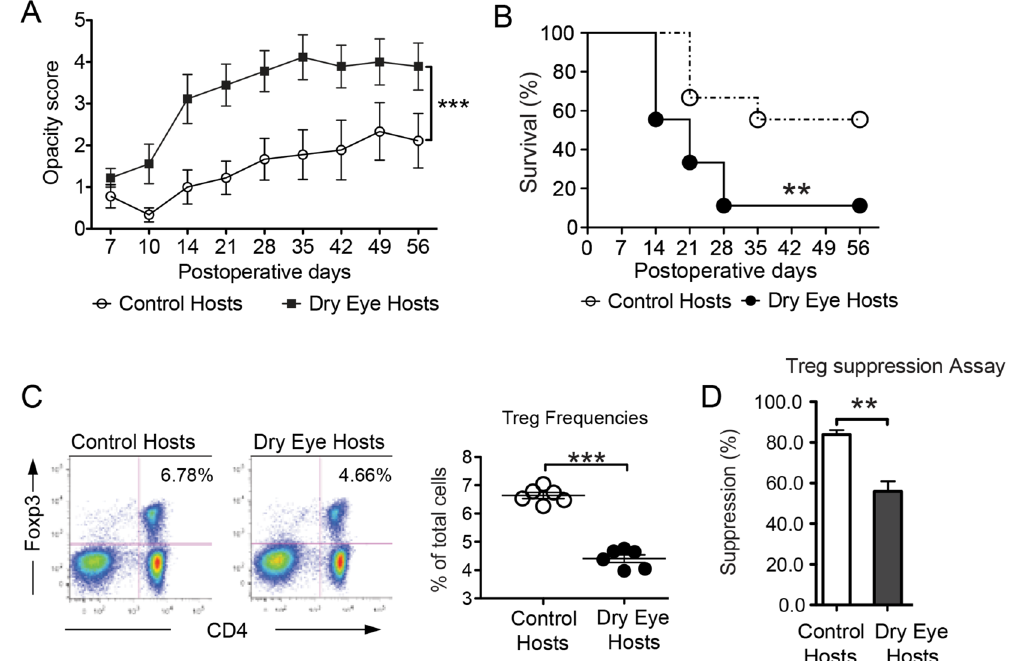
Figure 1. Dry eye disease reduces graft survival and Treg function after allograft survival. Healthy corneal grafts were transplanted on normal control hosts or dry eye (DED) hosts. ( A ) Corneal graft opacity ( *** p < 0.001) and ( B ) graft survival were assessed for 8 weeks (n = 10/group, ** p < 0.01). Draining lymph nodes were harvested 2 weeks post-transplantation. Single cell suspensions were analyzed by flow cytometry. ( C ) Frequencies of CD4 + Foxp3 + Tregs from control vs. DED hosts was determined using flow cytometry (n = 5 and *** p < 0.001) ( D ) Treg suppression assay (n = 6) was performed using CD4 + CD25 − responders from rejected control hosts, and CD4 + CD25 + Tregs from control and dry eye hosts ( ** p < 0.01). Data is presented as mean ± SEM (error